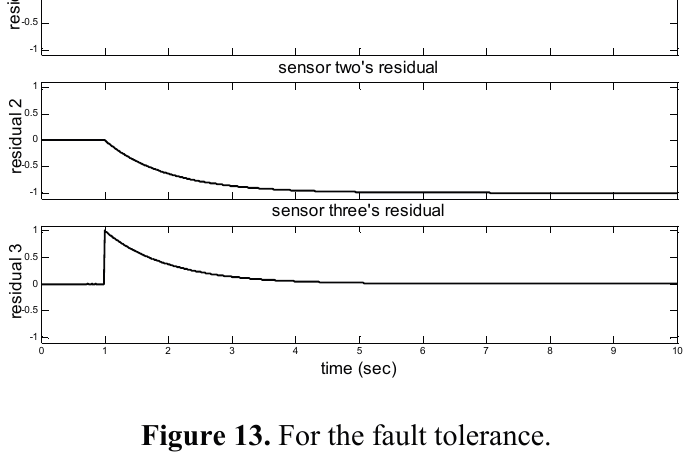
Figure 13. For the fault